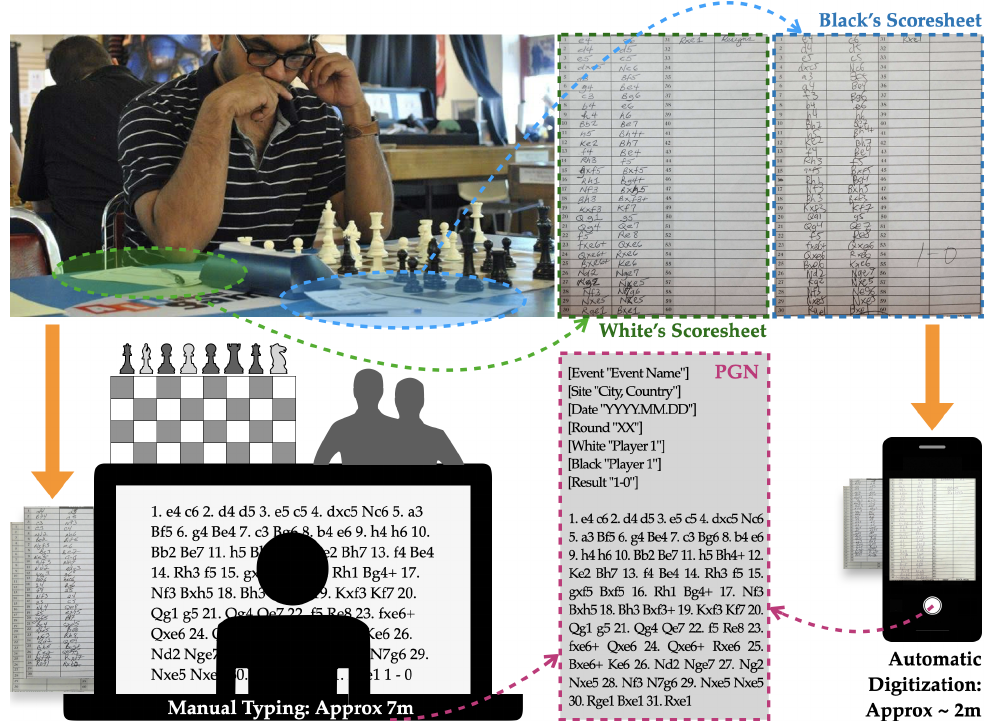
Figure 1. Schematics of an OTB chess event and scoresheet digitization process. Top images show the record keeping of moves and collected scoresheets from the players. Bottom left shows a potential workflow of manual typing and occasional necessity of a chess board or calling out the players for confusing cases. Bottom right shows the proposed automatic workflow of scoresheet digitization which is mostly based on taking pictures with a mobile